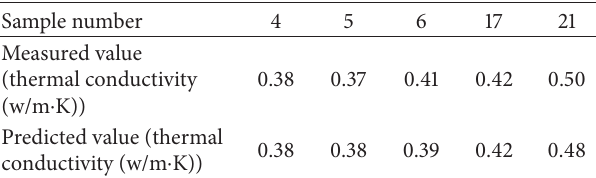
Table 4: Prediction results of thermal conductivity for test samples.